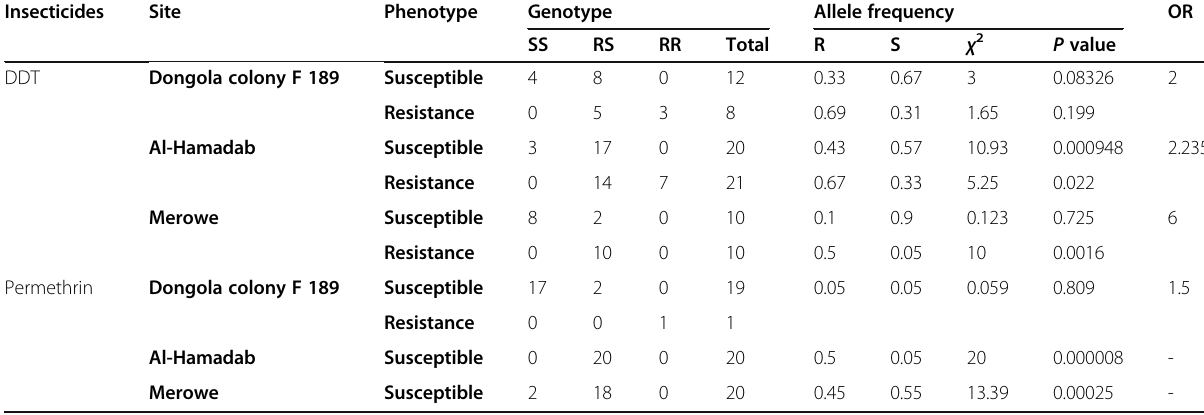
Table 6 L1014F alleles frequencies detected in mosquitoes of An . Arabiensis exposed to DDT and permethrin